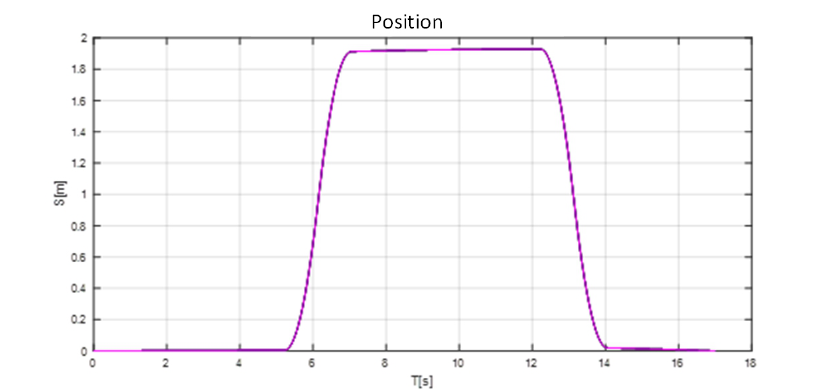
Figure 9. Graph of traveled distance calculated from data registered by the MTi XSENS installed on the robot flange and welding gun for the V2000, ACC